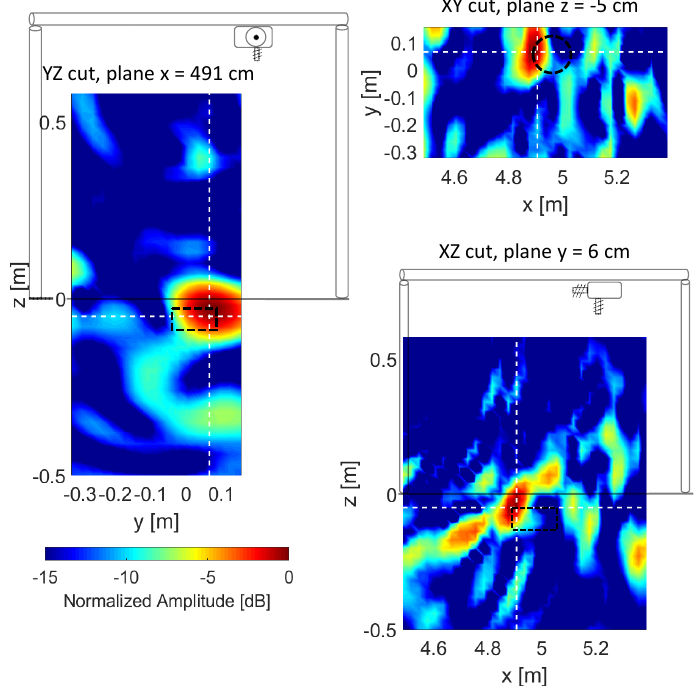
Figure 11. Imaging results for the buried plastic landmine. GPR-SAR cuts are centered at the position of the target, the profile of which is highlighted with a black dashed line. For reference purposes, the air–ground interface (z = 0 m) and a sketch of the layout of the portable setup are depicted in black color in the YZ and XZ cuts.